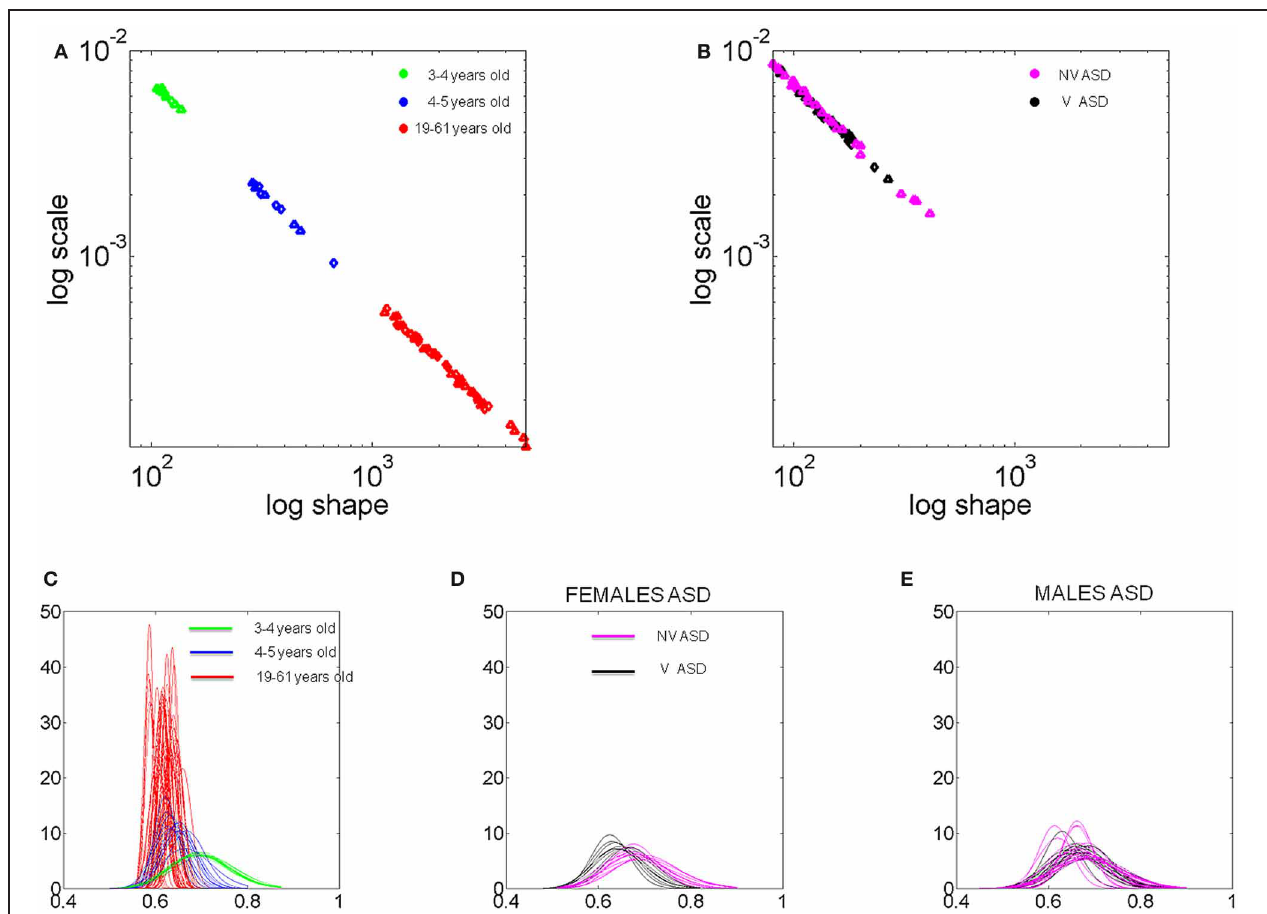
FIGURE 7 | Typical and atypical development of micro-movement patterns. The stochastic signatures of velocity-dependent variability captured in the normalized maximum speed (V max /(V max + V avrg )) of hand pointing motions across different ages. The shape and scale estimated parameters of the continuous two-parameter Gamma probability distribution family uniquely labels each individual in the group (78 participants total). (A) Fourty-four typical controls self-cluster by age along the line of unity on the log-log Gamma plane according to a scaling power law. (B) Thirty-four participants with ASD also align on the line of unity. Notice that the 34 ASD participants include verbal and non-verbal subjects, spanning from 4 to 25 years of age, yet they all fall along the statistical region of the TD 3–4 years old. (C) Estimated probability distributions of the velocity-dependent parameter for all TD subjects using their empirically obtained hand speed profiles. Notice that the noise-to-signal ratio changes dramatically from 3–4 to 4–5 years of age